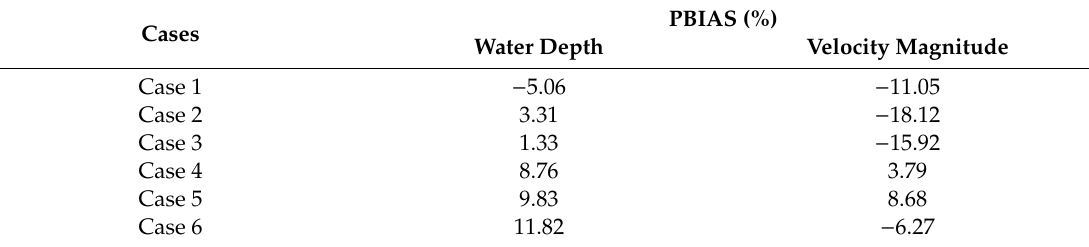
Figure 6. Example comparison of experimental and simulated three-dimensional velocities and water depths. Table 5. Percent bias (PBIAS) of the considered